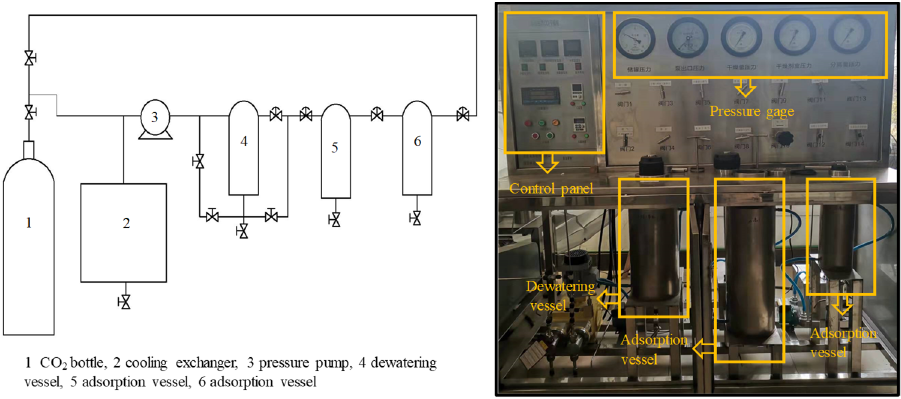
Figure 2. Configuration and photos of the supercritical CO 2 dewatering plant.